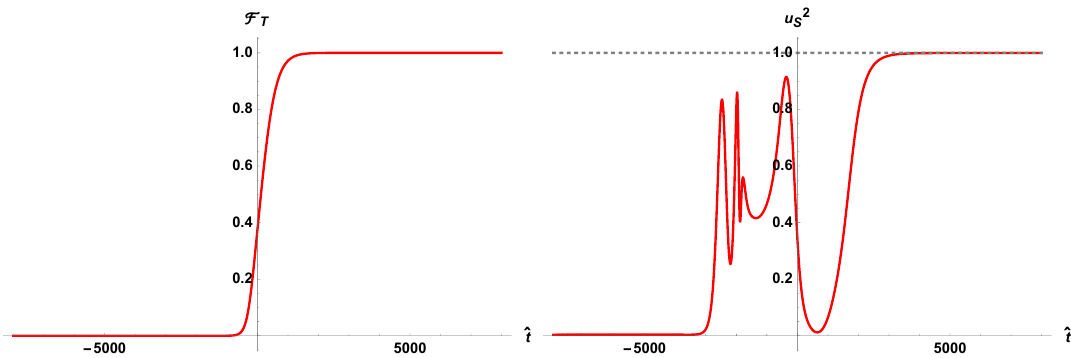
(right panel) for the model of appendix F: contrac- S